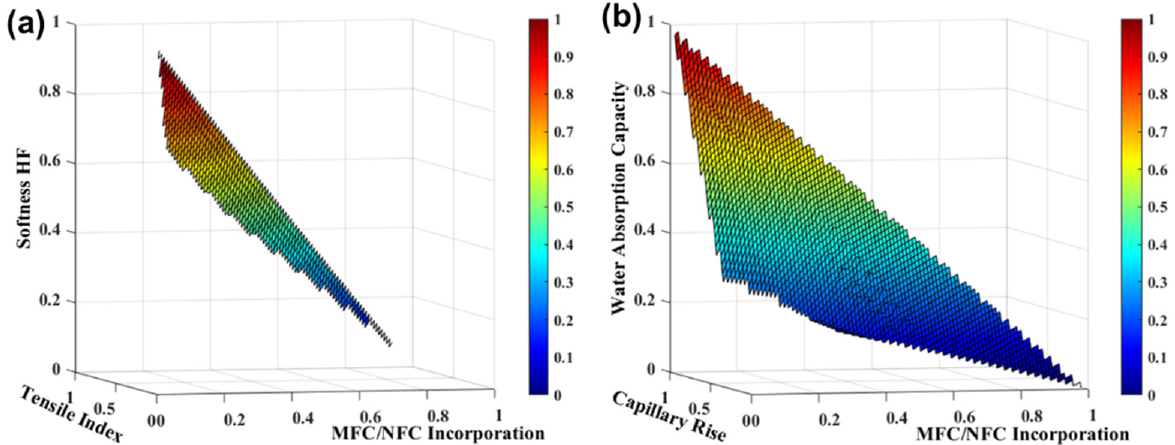
Figure 7. TSA-softness HF softness and tensile index properties ( a ) and water absorption capacity and capillary rise ( b ) with MFC/NFC incorporation in a eucalyptus slush pulp. The variables were normalized.